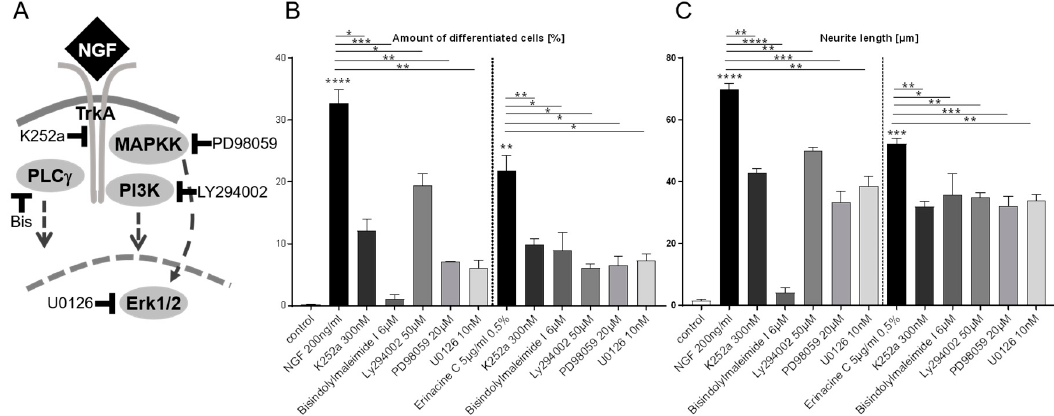
Figure 2. Erinacine C induced neurotrophic activity mediates PC12 differentiation via MAPK/ERK, PLC γ and PI3K signaling. ( A ) Schematic drawing of signaling pathways downstream of the NGF-activated TrkA receptor and respective pharmacological inhibitors. ( B ) Percentage of PC12 cells differentiated into neuron-like cells upon stimulation with either recombinant NGF (left) or conditioned medium of erinacine C treated 1321N1 astrocytoma cells (right) in the presence of signal transduction cascade inhibitors (two independent fields, n = 100 cells; three independent cultures). ( C ) In the same cultures individual neurite length of differentiated cells were measured and are displayed as average values ( n = 180 cells, three independent cultures) as an indication of the extent of differentiation. * p < 0.05, ** p < 0.01, *** p < 0.001, **** p < 0.0001.